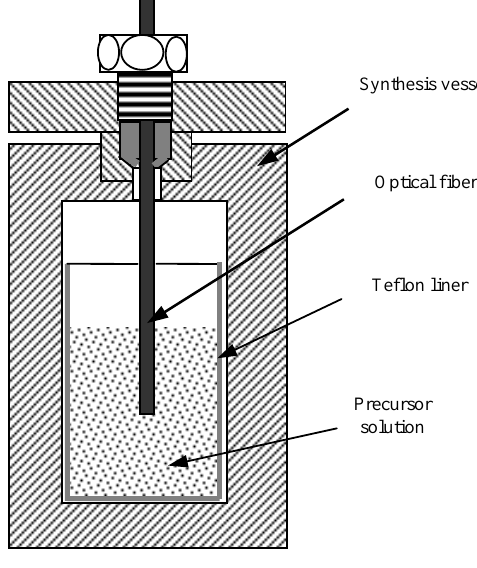
Figure 1. Schematic of the synthesis reactor showing the cleaved fiber endface facing